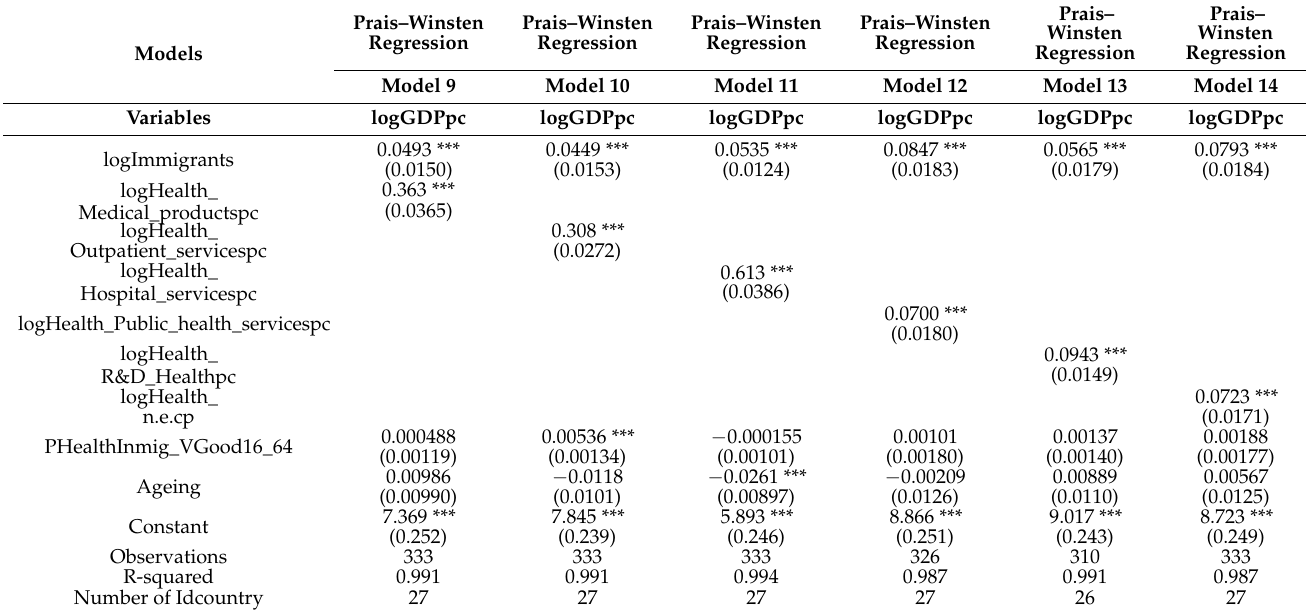
Table 4. Prais–Winsten Regression models with breakdown of public health expenditure by function.